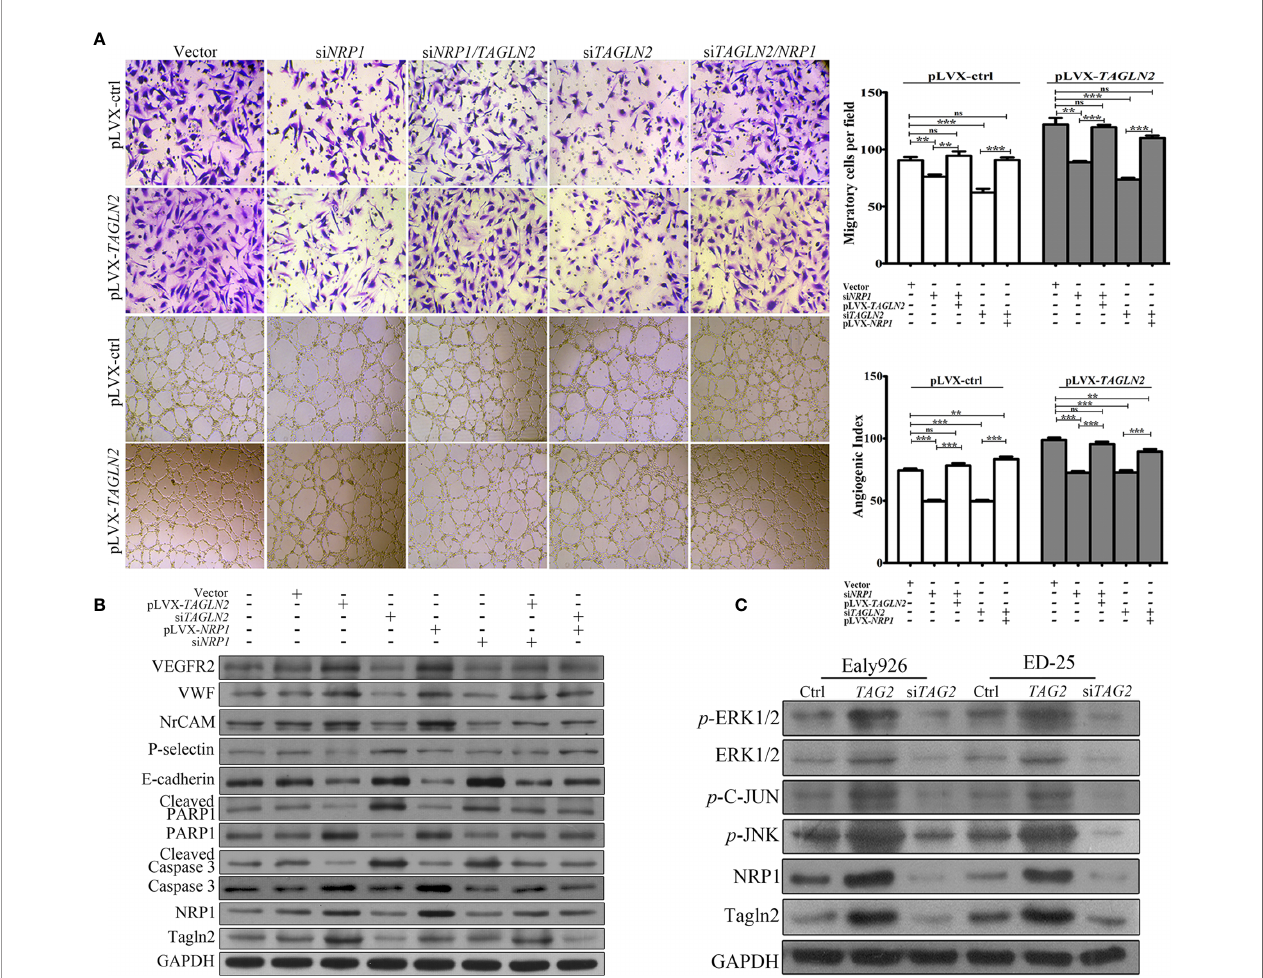
FIGURE 5 | NRP1 mediated the angiogenic function of Tagln2. (A) Migration and in vitro tube-forming activity of control Ealy926 cells (pLVX-ctrl) and Ealy926 cells with stable expression of TAGLN2 (pLVX- TAGLN2 ) subjected to a series of treatments, including knockdown of endogenous NRP1, knockdown of endogenous Tagln2, knockdown of endogenous NRP1 with exogenous replenishment of Tagln2 or knockdown of endogenous Tagln2 with exogenous replenishment of NRP1. (B, C) After modulation of TAGLN2 and NRP1 expression in ECs, levels of VEGFR2, VWF (markers of endothelial cells), NrCAM (mediating capillary outgrowth), E-cadherin, P-selectin (related to ECs adhesion and migration), Caspase 3/cleaved Caspase 3 and PARP1/cleaved PARP1 (markers of apoptosis), as well as downstream targets, including phosphorylated ERK1/2, JNK, and C-Jun, were measured by western blotting. GAPDH was used as the loading control. ** P < 0.01, *** P < 0.001. ns, not signi fi